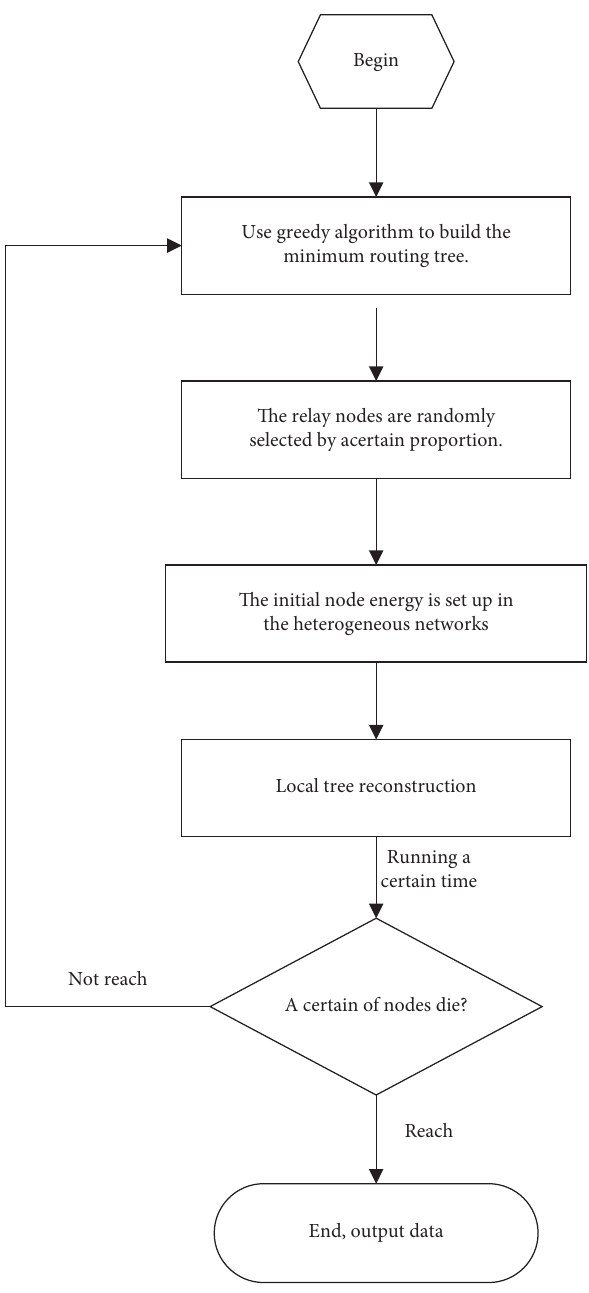
Figure 6: Flow chart of the